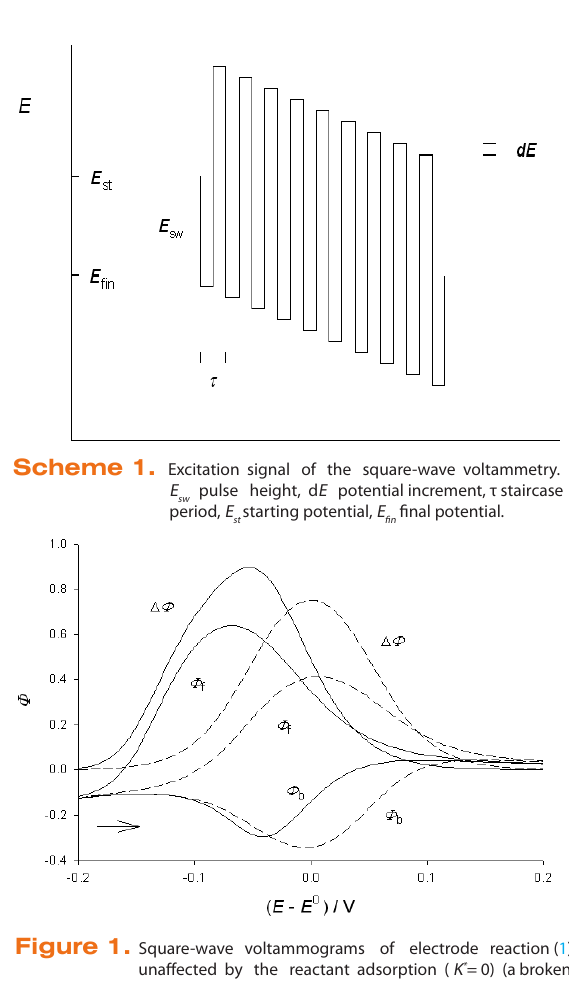
> 10 5 ) (a full line). ads = 50 mV. A net sw ) and backward (Φ ) f b